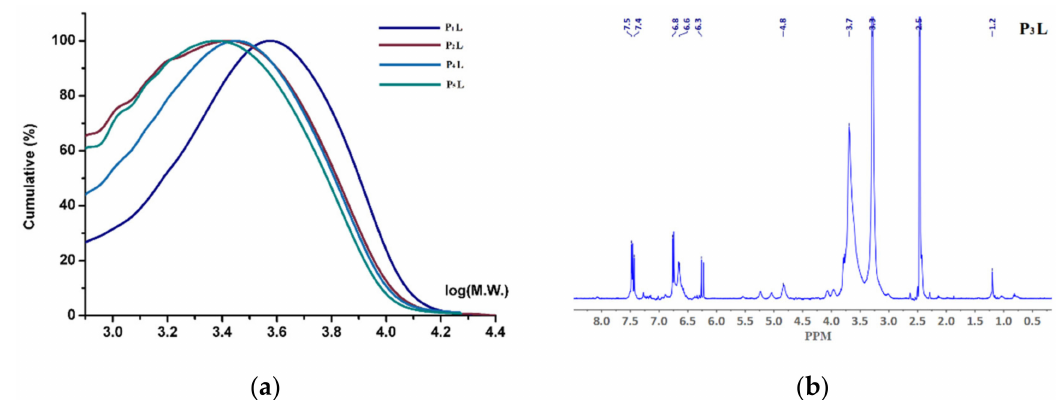
Figure 6. ( a ) Molecular weight distribution (P 1 L, P 2 L, P 4 L, and P 5 L); ( b ) 1 H NMR spectrum of the selected lignin fractions (P 3